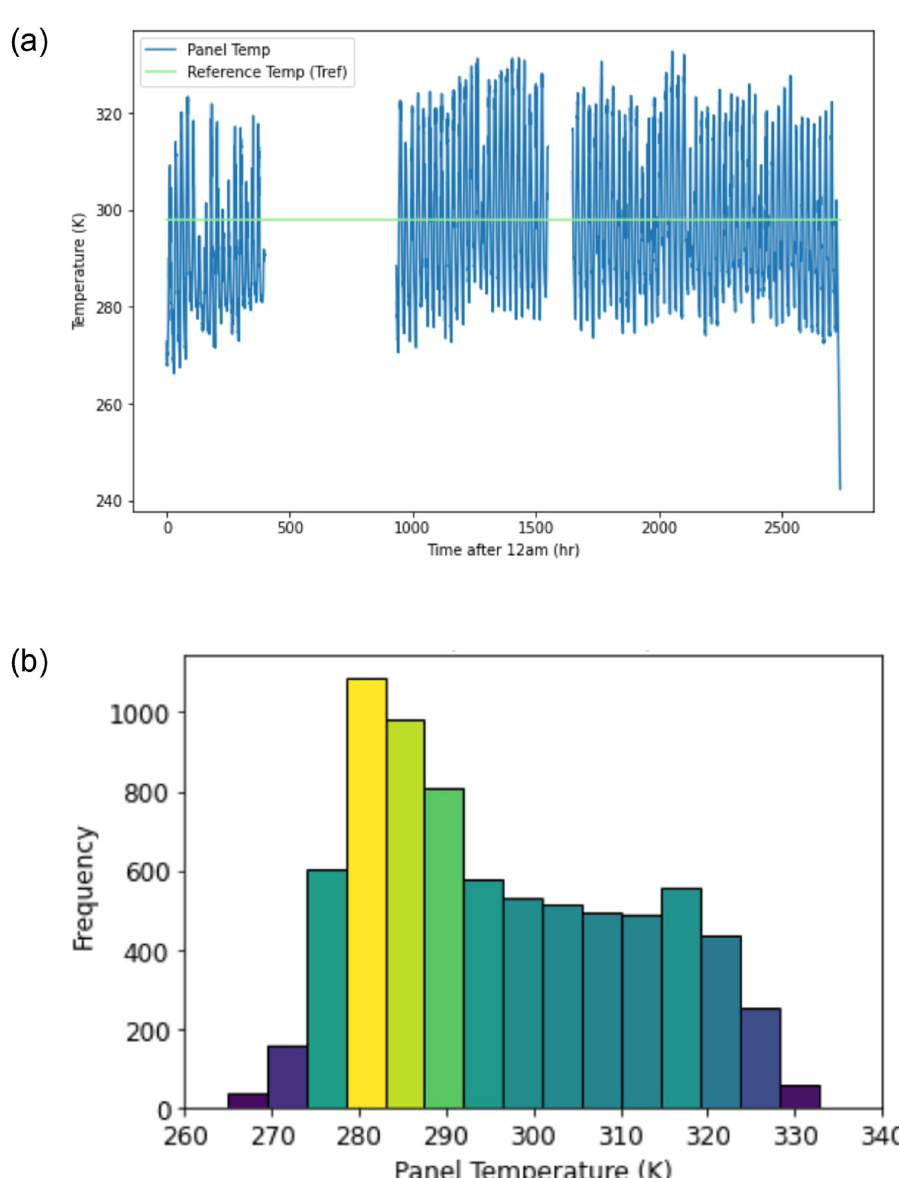
including panel height, panel length, tilt, array width, and distance between rows. Since the longwave radiation did not account for edge effects on the row ends, shortwave values were extracted from along the center of the